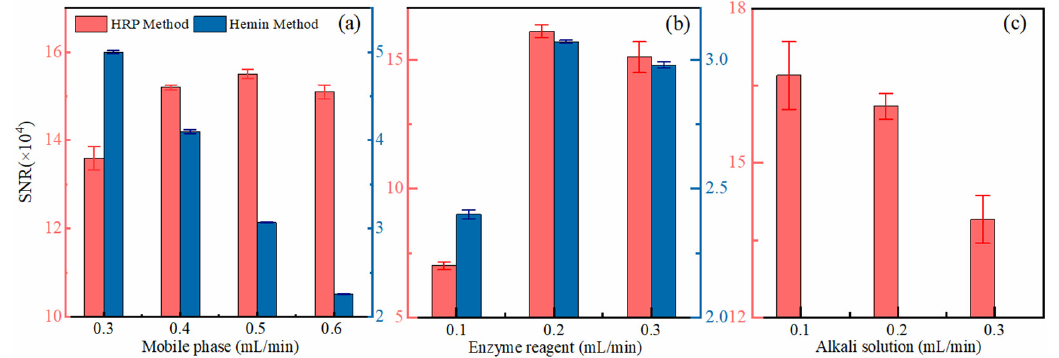
Figure 5. The results of two methods under different flow rates of ( a ) mobile phase, ( b ) enzyme reagent, and ( c ) alkali solution.